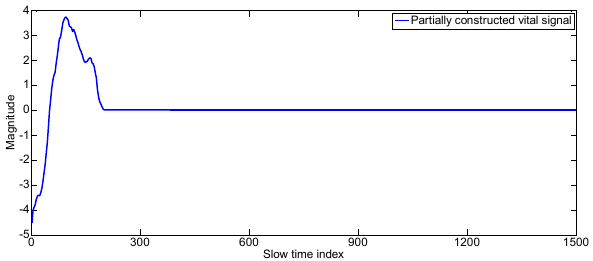
Figure 8. The first sub-signal component of vital_constructed_signal.